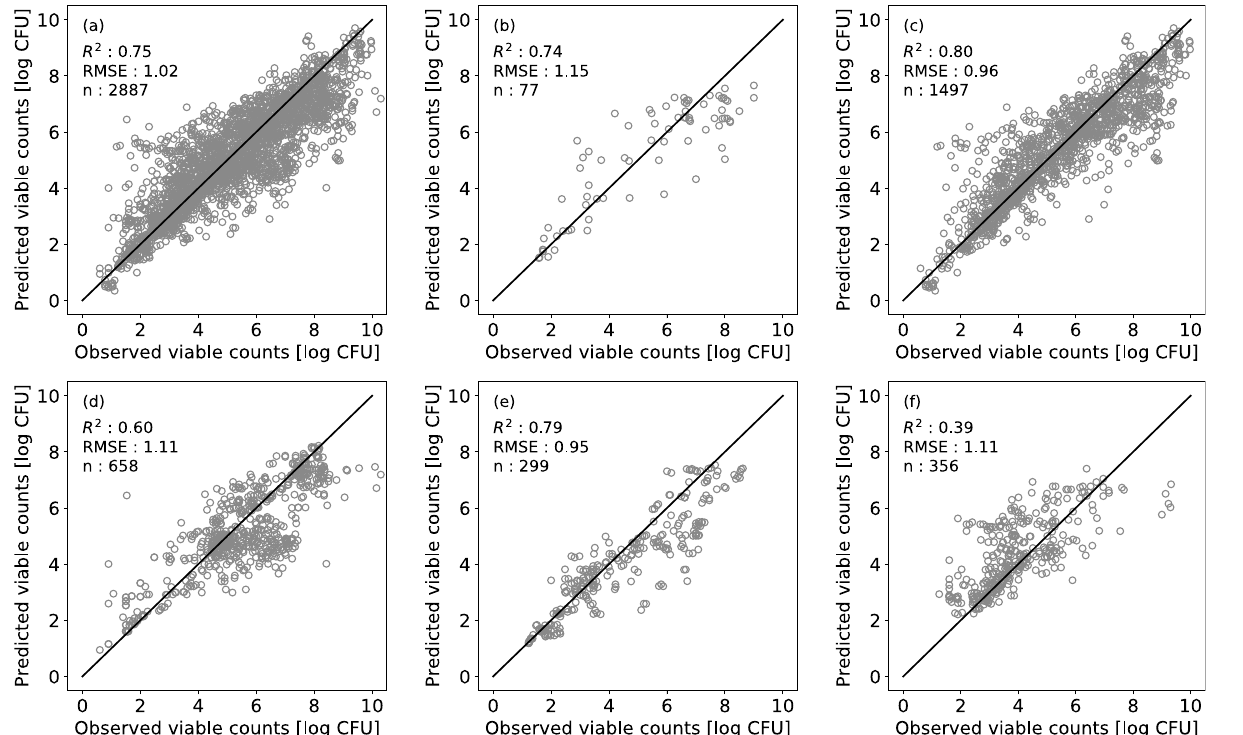
Figure 3. Comparison the observed and predicted values for test data of all food categories ( a ), beef ( b ), culture medium ( c ), pork ( d ), seafood ( e ), and vegetables ( f ). The solid line represents residuals (r) = 0 (log